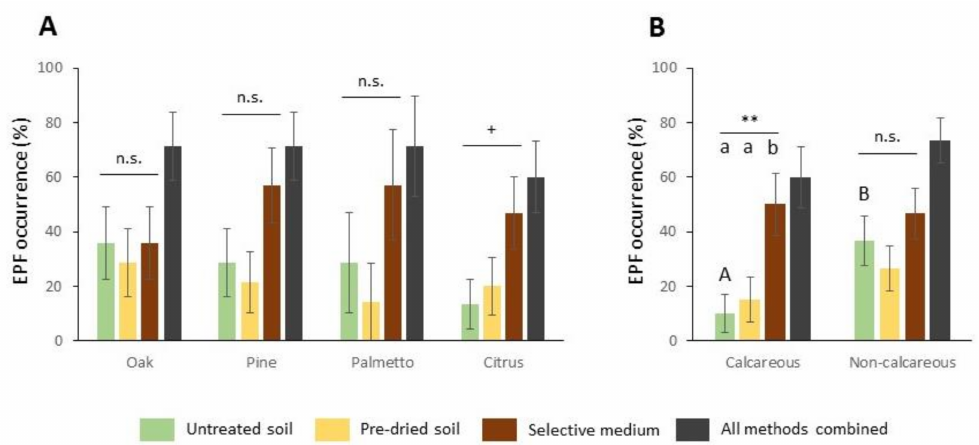
Figure 4. Comparison of entomopathogenic fungi (EPF) recovery frequency using di ff erent isolation methods depending on two ecological drivers ( A ) botanical habitats; ( B ) soil ecoregion. Asterisks indicate significant di ff erences within treatment comparisons at ** p < 0.01, + p < 0.1 and n.s., not significant. Di ff erent letters indicate significant di ff erences in Tukey’s test (HSD) ( p < 0.05). Values are least-square means ±